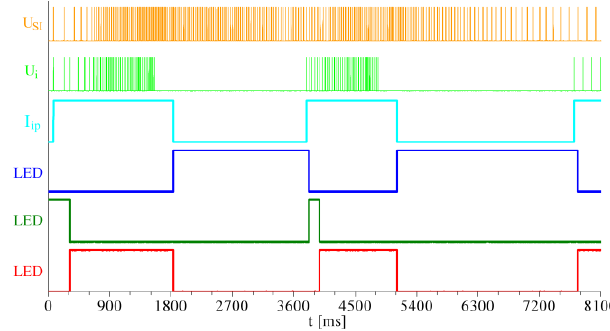
Fig. 8. Test results for the indicator of the type of a mixture All signals in the figure above are two-state